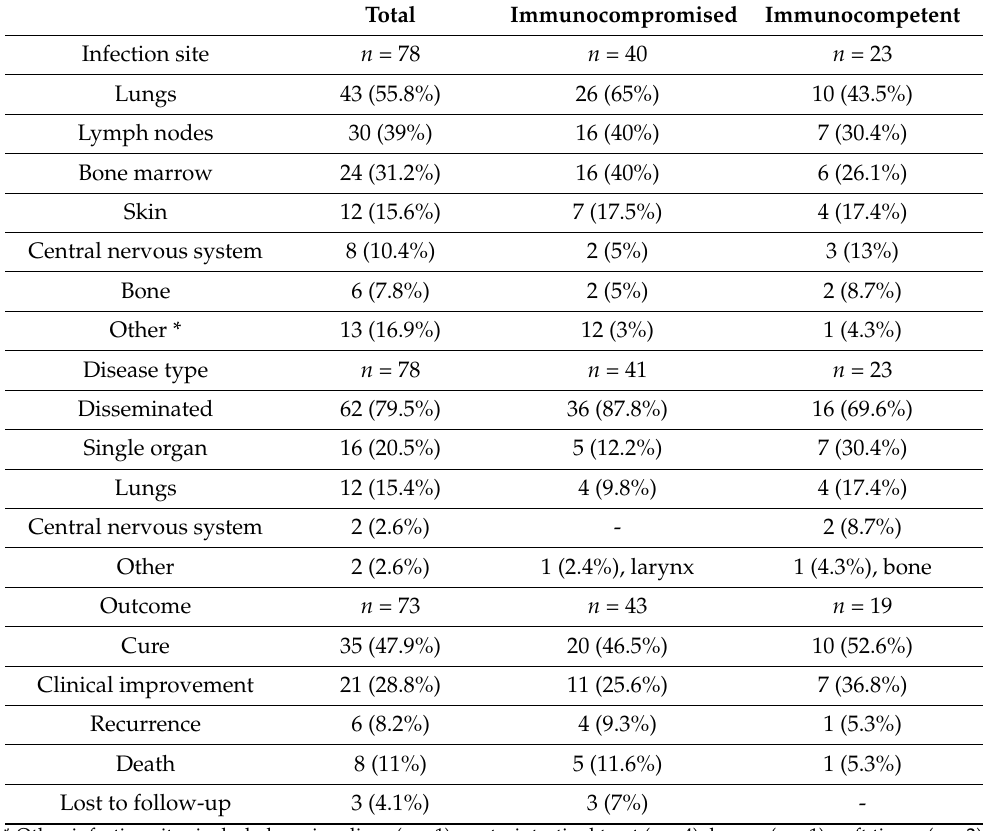
Table 3. Disease characteristics and outcome compared between immunocompetent and immuno- compromised children with histoplasmosis.